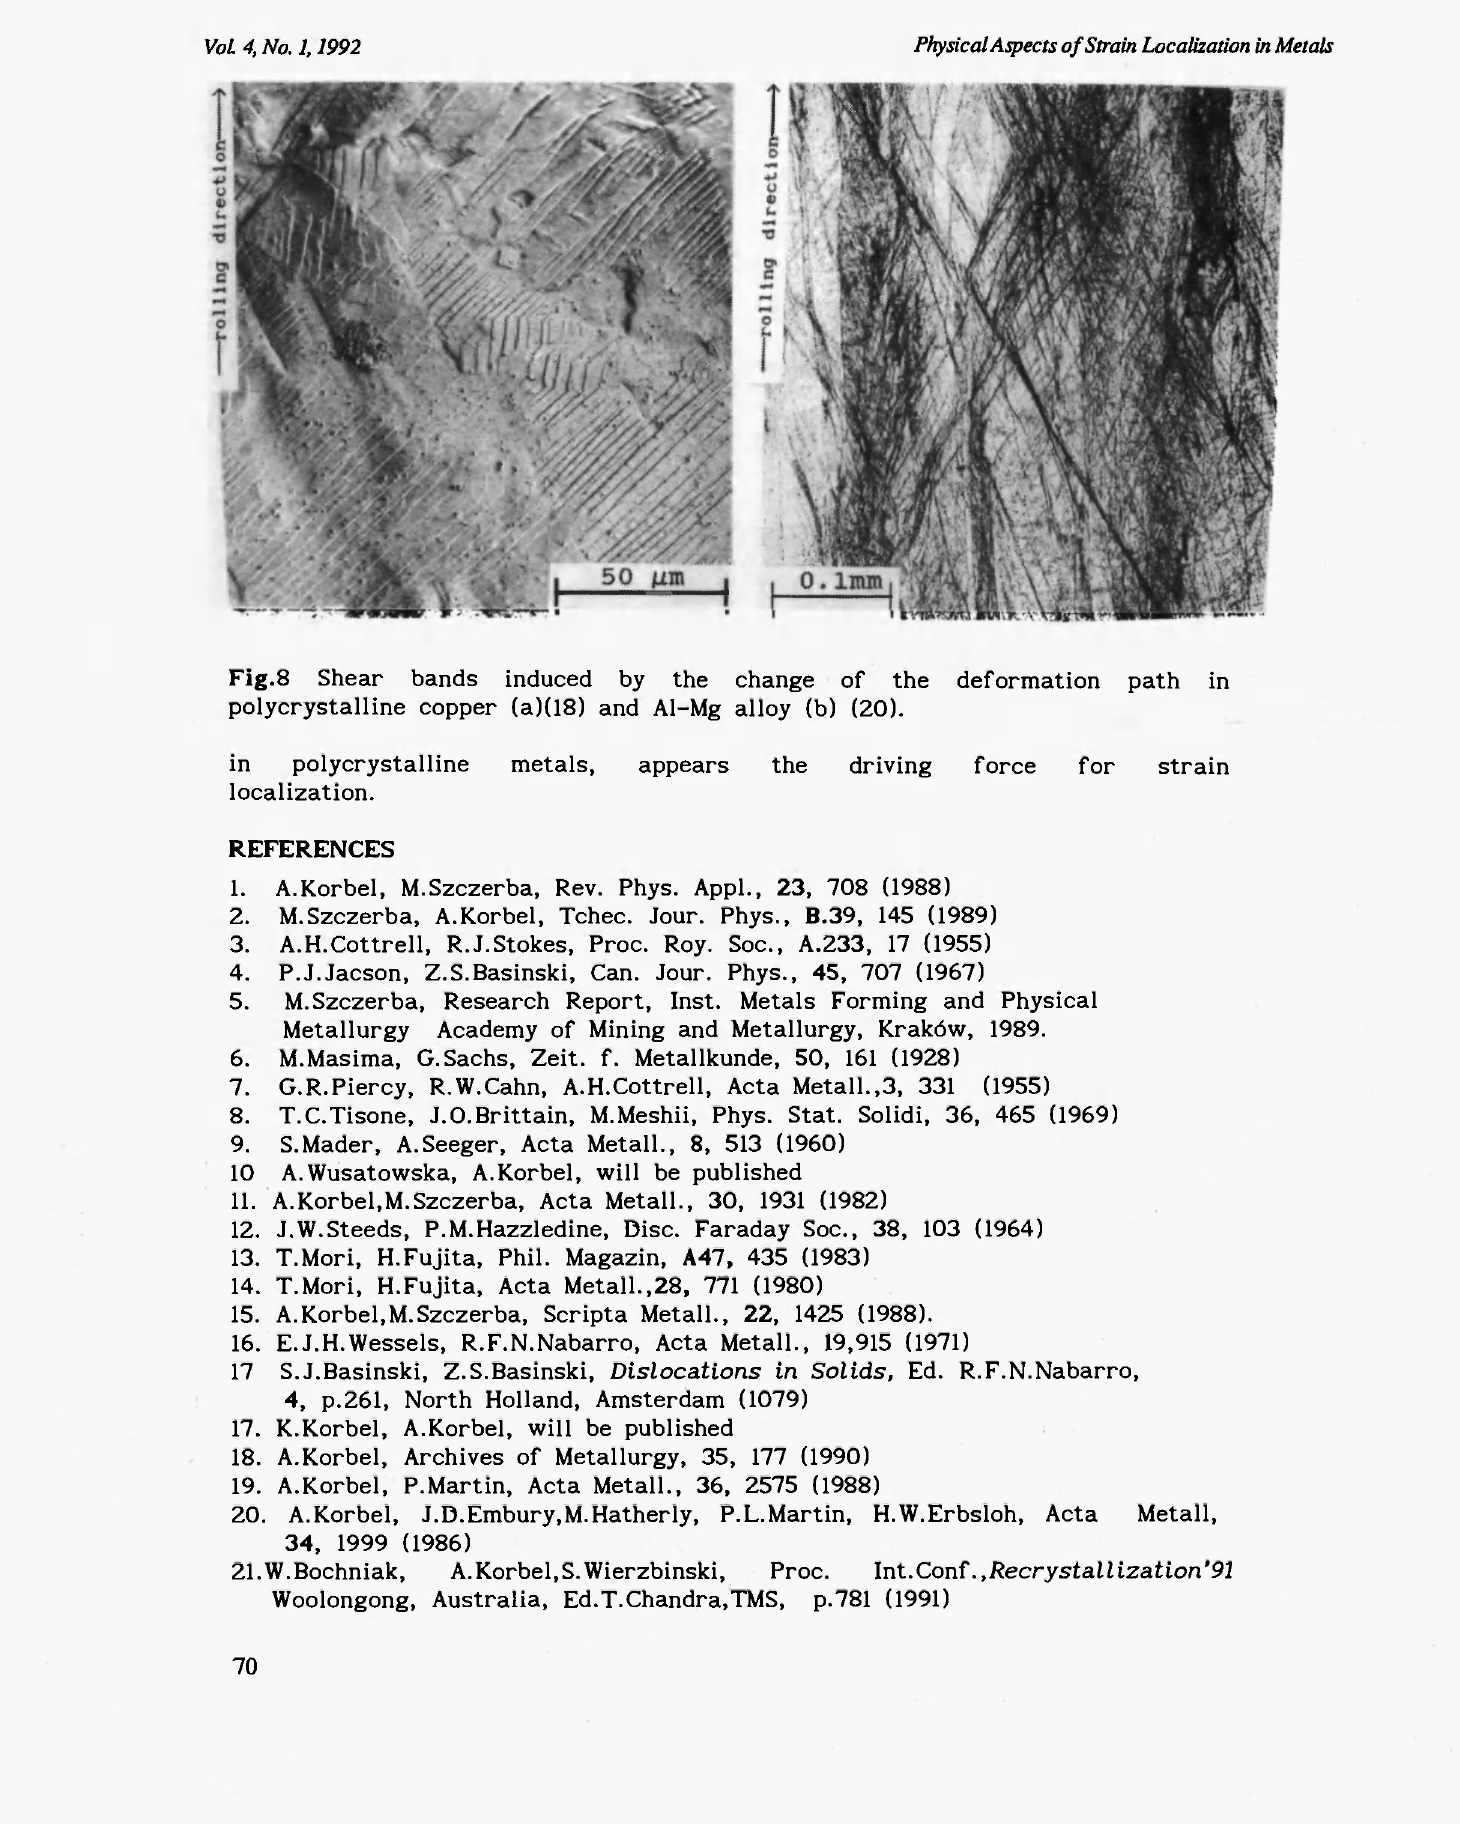
Fig. 8 Shear bands induced by the change of the deformation path in polycrystalline copper (a)(18) and Al-Mg alloy (b) (20). in polycrystalline metals, appears the driving force for strain